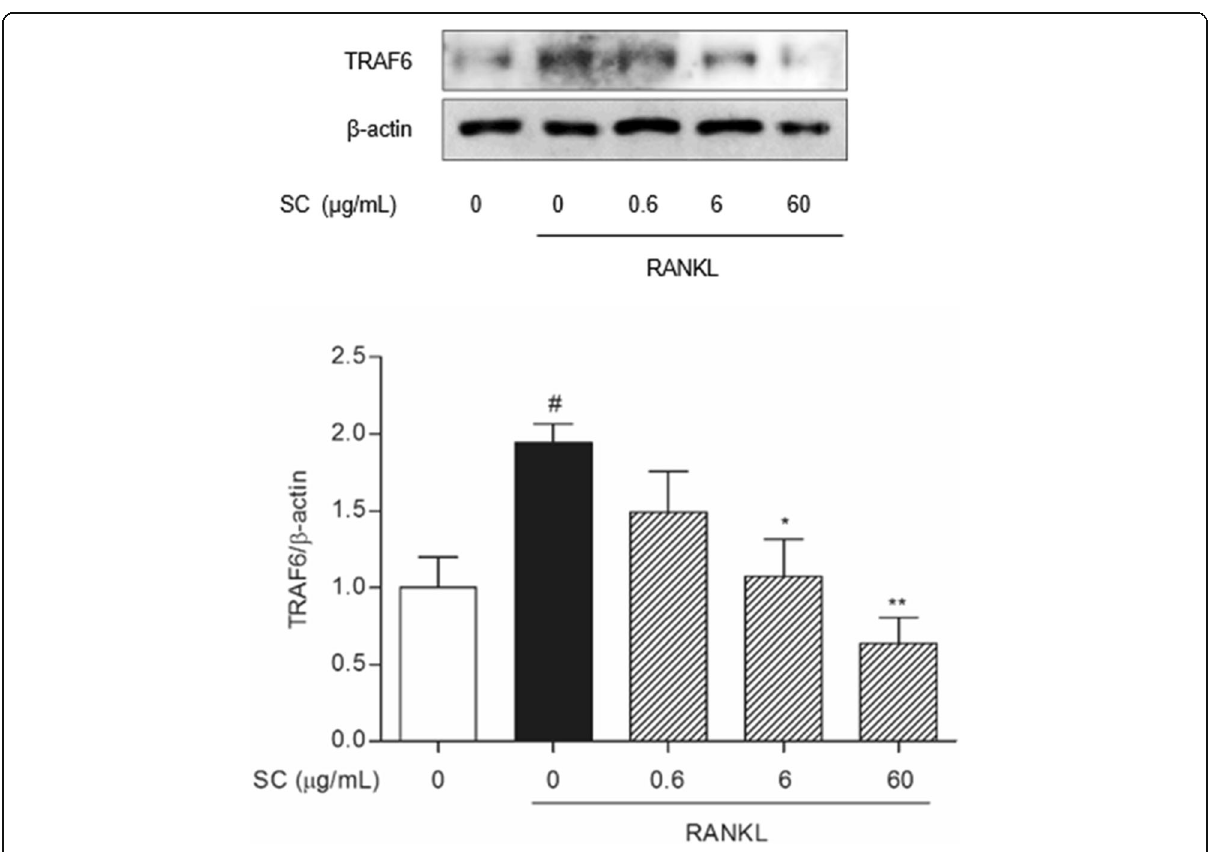
Fig. 3 The effect of SC on TRAF6 protein expression in RANKL-stimulated RAW 264.7 cells. RAW 264.7 cells (8 × 10 4 per well) were incubated with 100 ng/mL RANKL or both RANKL and SC (0.6, 6 and 60 μ g/mL). After 7 days, total protein was then isolated and protein expression levels were evaluated by Western blot assay. Data are represented as the means ± S.E.M. of three independent experiments. # p < 0.05 compared with non- treated cells. * p < 0.05 and ** p < 0.01 compared with only RANKL-treated